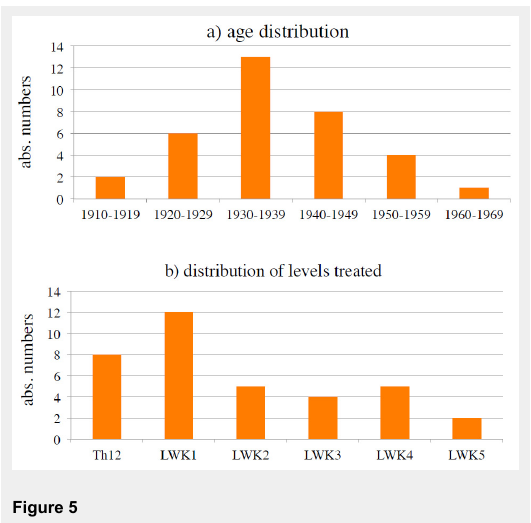
Stentoplasty patients (n = 34): a) age distribution of patients treated, b) distribution of levels treated.